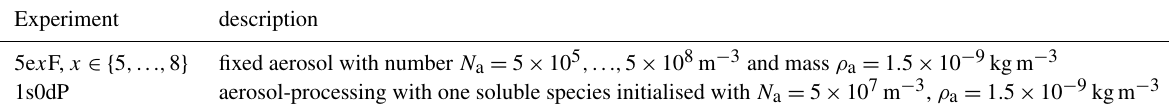
Table 1. Descriptions of the model experiments. Experiment